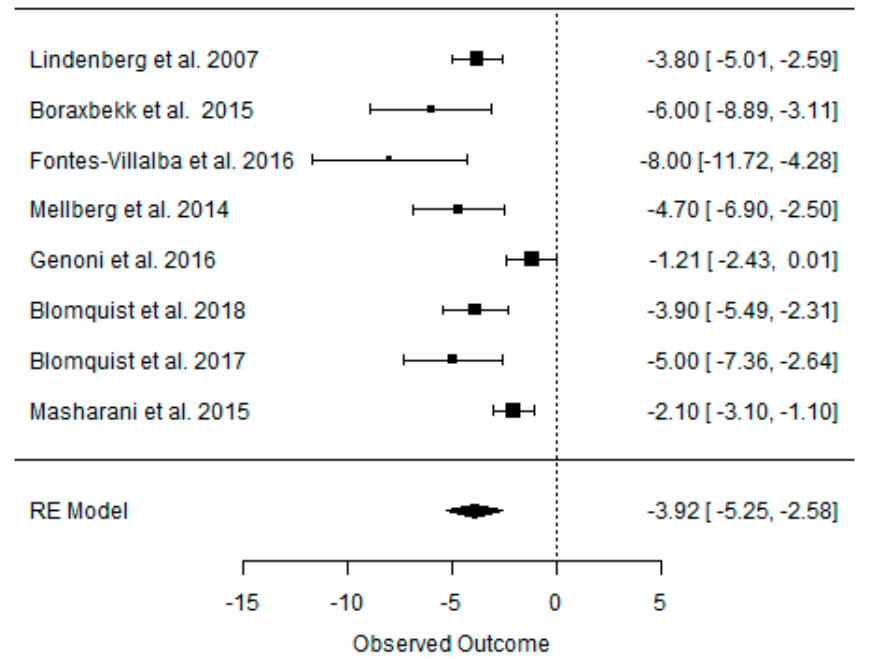
Figure A3. Forest plot of the effect of a CD on BM (kg) in the short term (weighted mean difference).